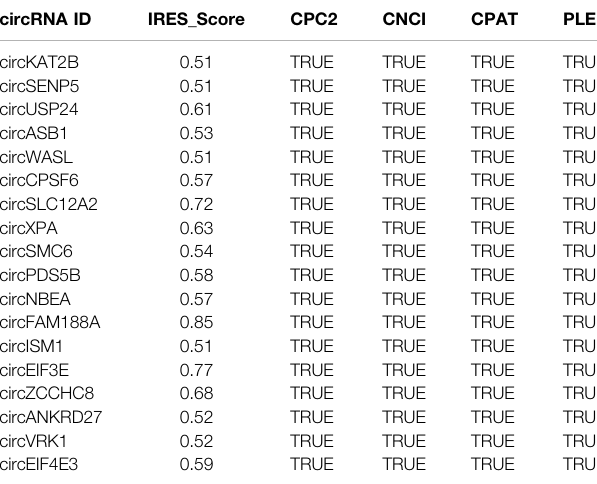
TABLE 3 | The predicted results for the coding potential of circRNAs. circRNA